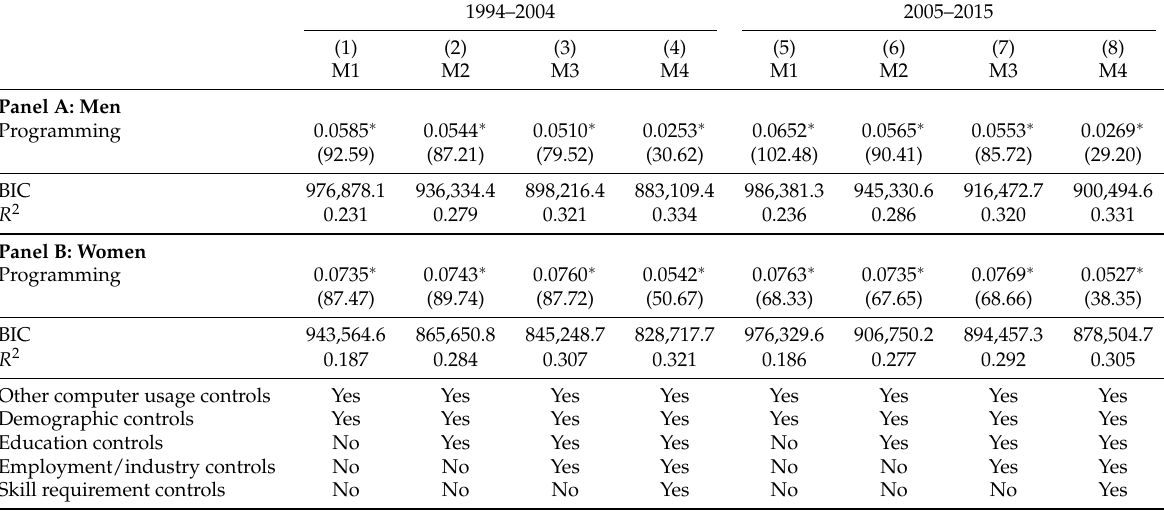
Table 2: Selected coefficients in regression models predicting log hourly wage by gender and